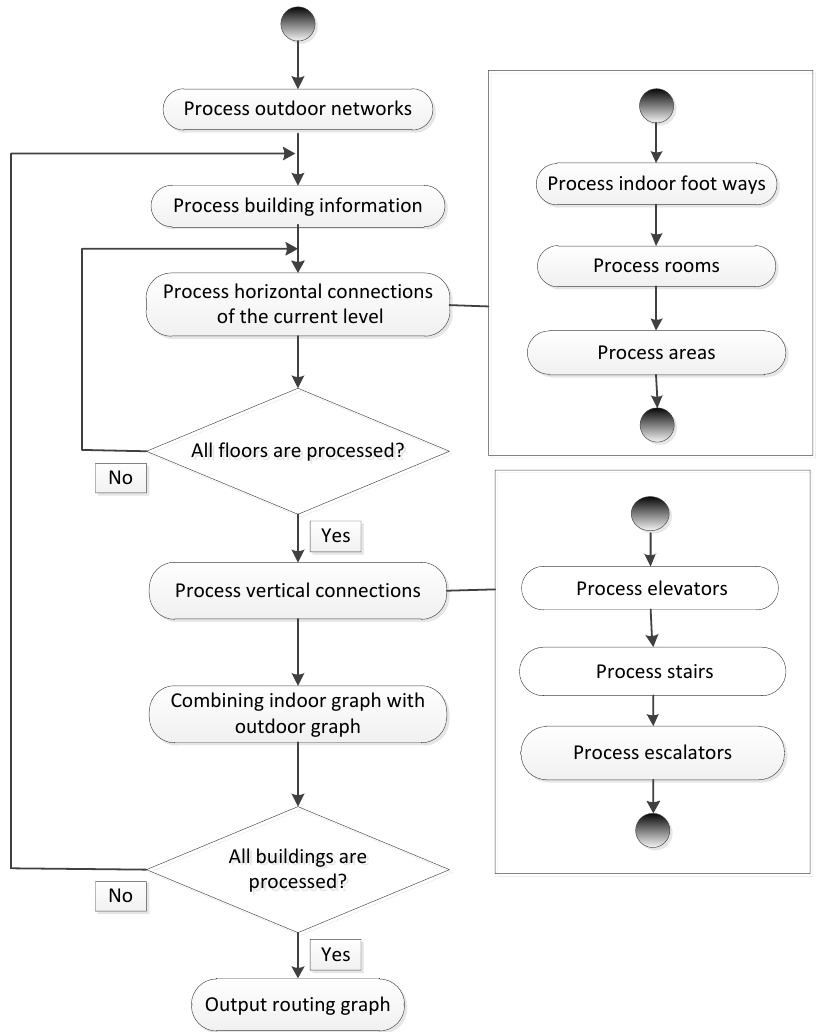
Figure 11. The workflow of generating the routing